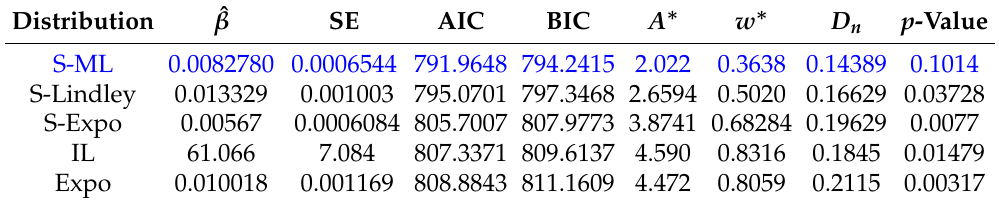
Table 5. ˆ β , SE and GOF metrics for the survival times of guinea pigs.